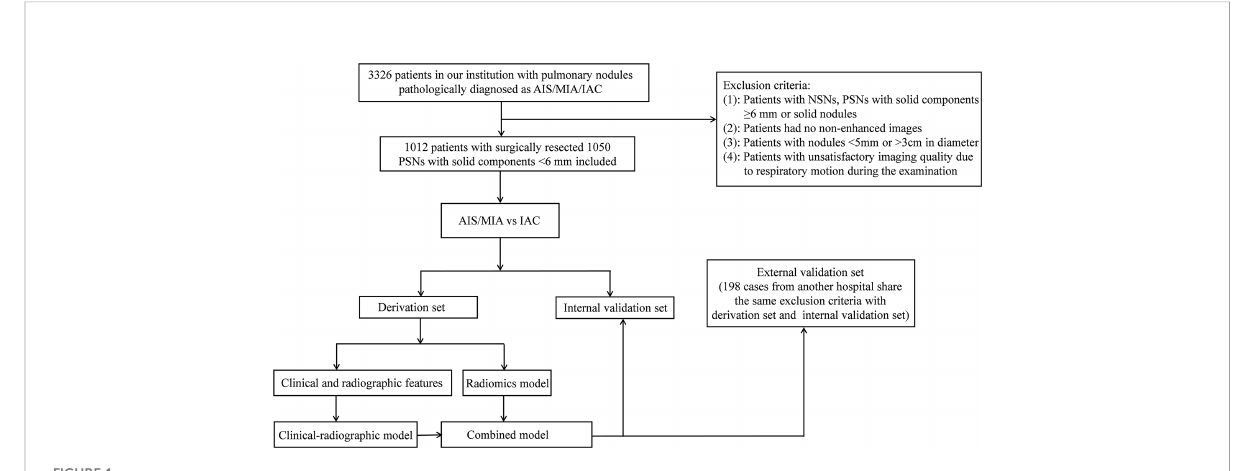
FIGURE 1 The work fl ow of our